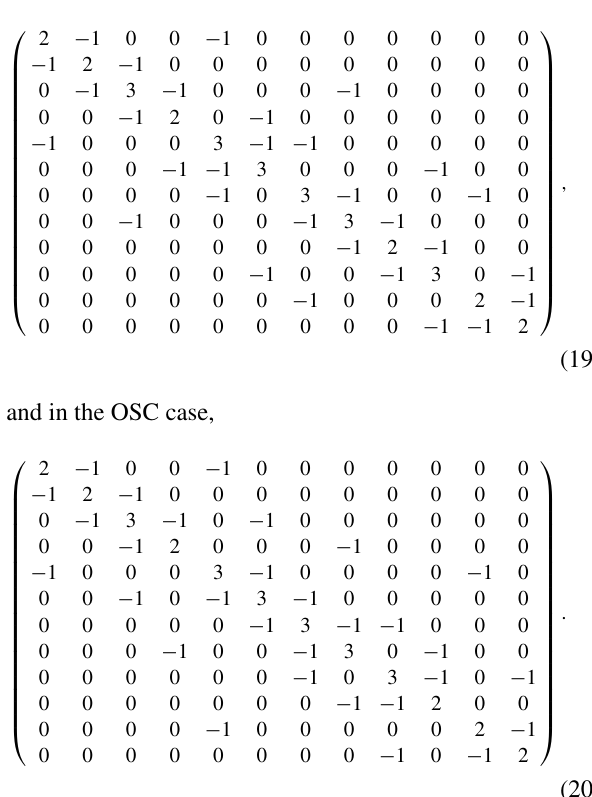
section, the adjacency matrix of G , A G , is the | V | × | V | square matrix with off-diagonal elements being the number of propagators connecting the vertex i with the vertex j . The Laplacian matrix corresponds to the difference of these two matrices: L G = D G − A G . As we will see, these matrices carry the topological information of the graph. For the sake of clarity, we explicitly write the Laplacian matrices associated to the diagrams in Fig. 2. In the CSC we have